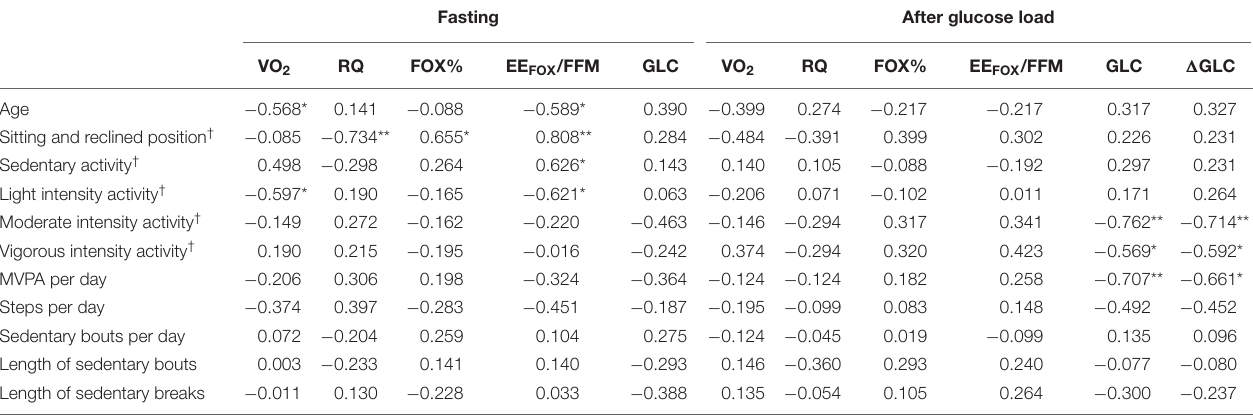
TABLE 3 | Metabolic parameters and glucose concentration in capillary blood measured at rest in fasting conditions and after a standardized glucose-rich meal. Fasting After load